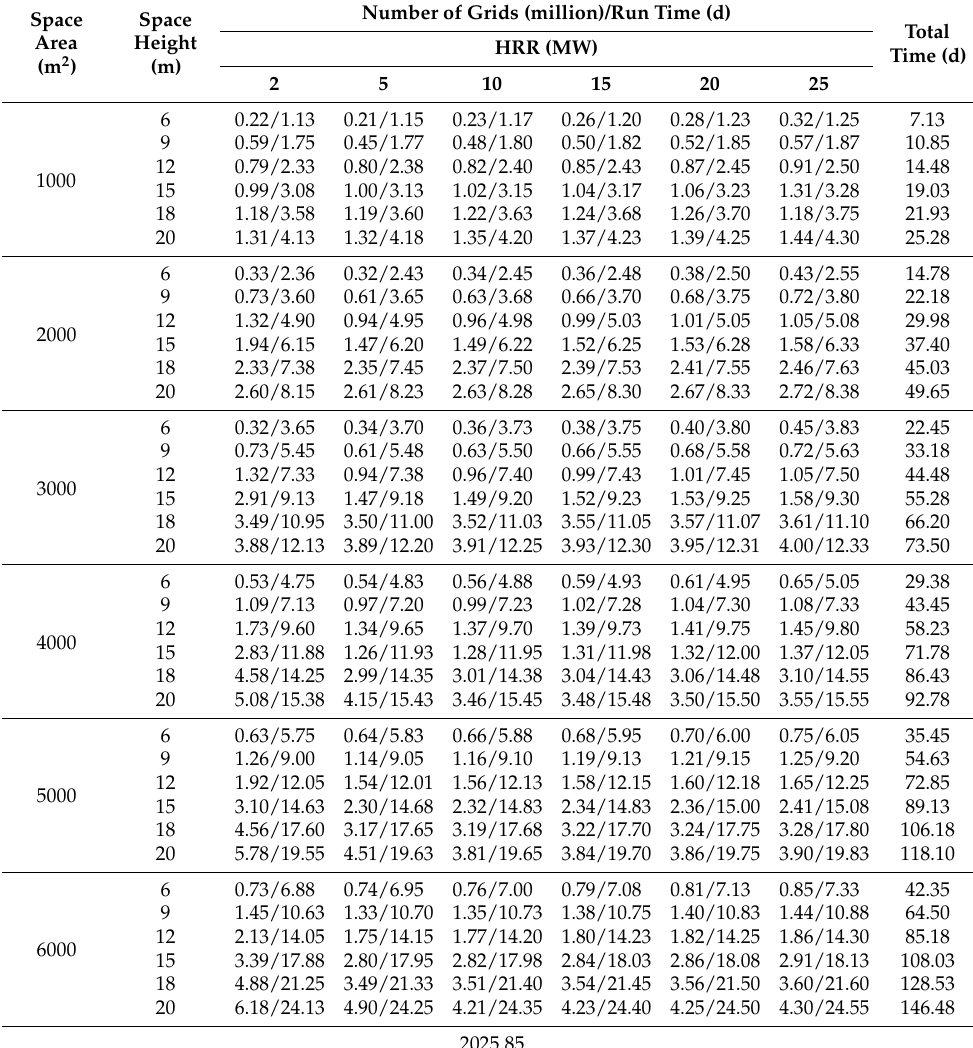
Table A1. Summary of simulation time under different simulation